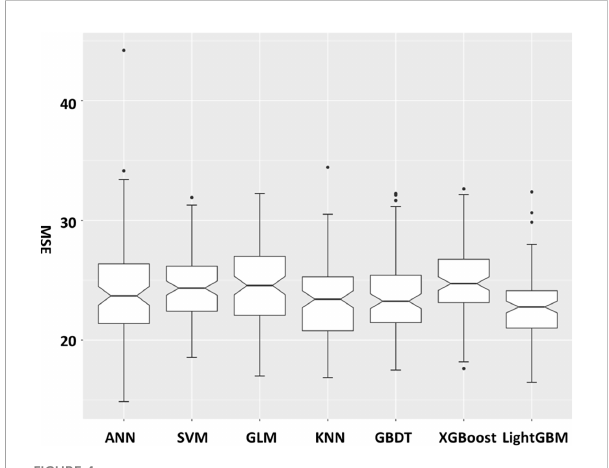
FIGURE 4 Mean squared error (MSE) after 10-fold cross-validation for the seven methods.